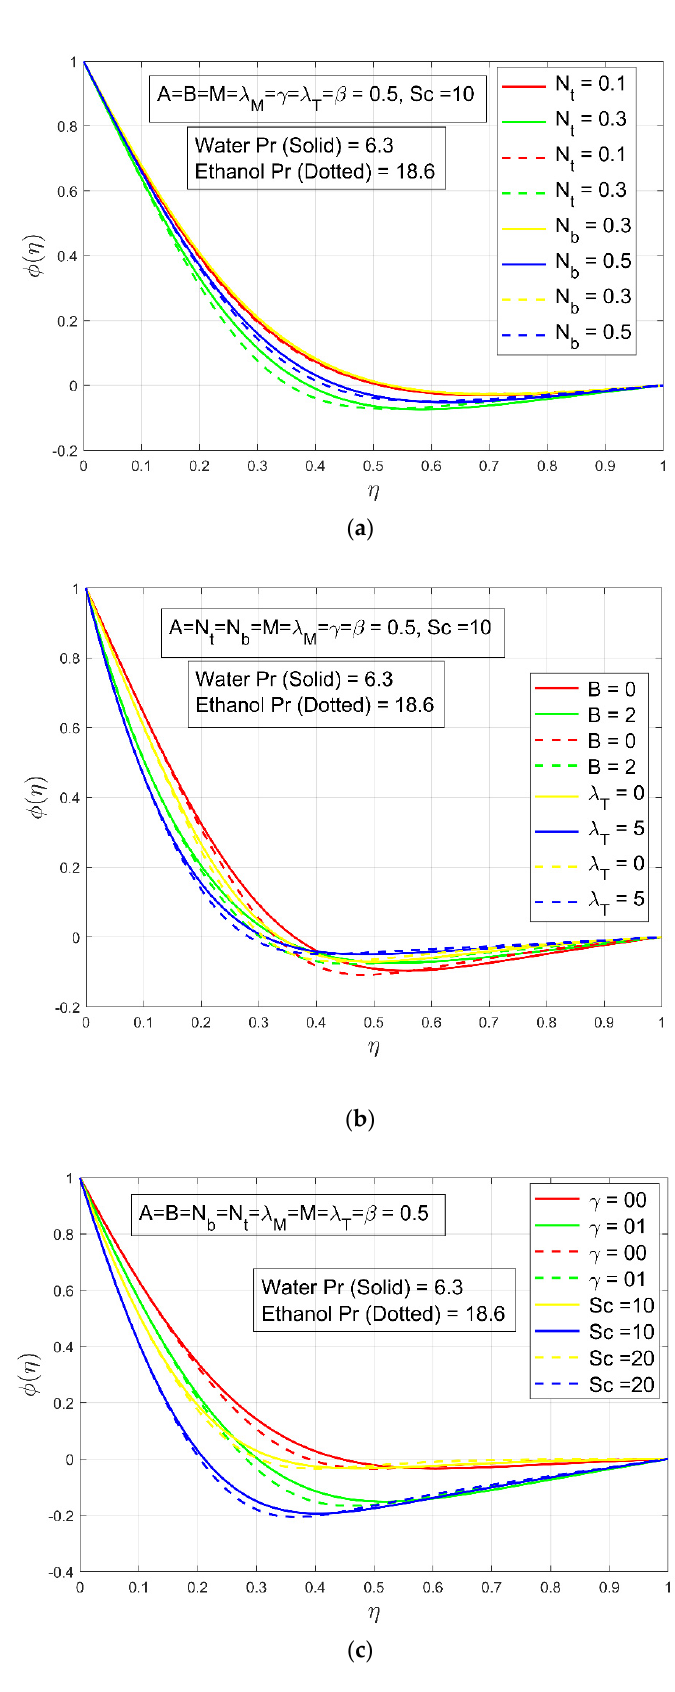
Figure 6. ( a ) The effect of N t and N b on concentration profile φ ( η ) ; ( b ) The effect of B and λ T on concentration profile φ ( η ) ; ( c ) The effect of γ and S c on concentration profile φ ( η )